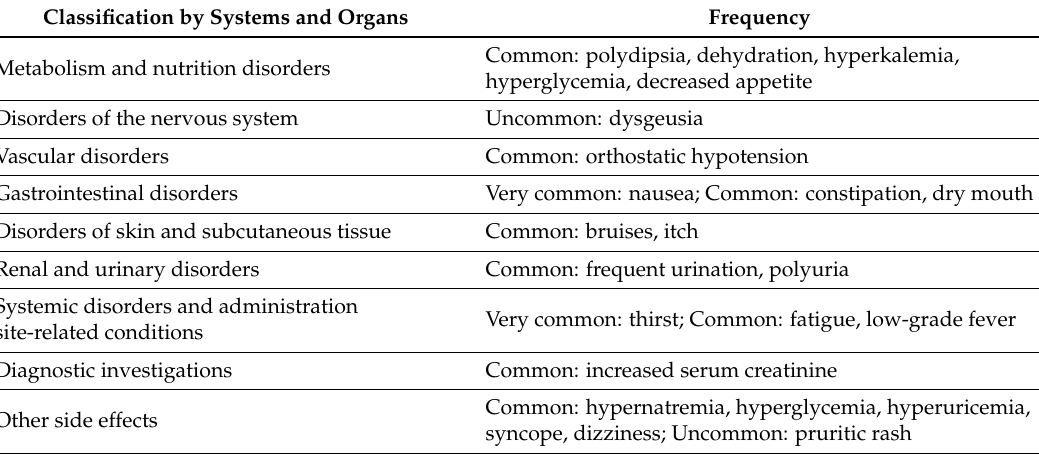
Table 6. Tolvaptan: recommendations for correct